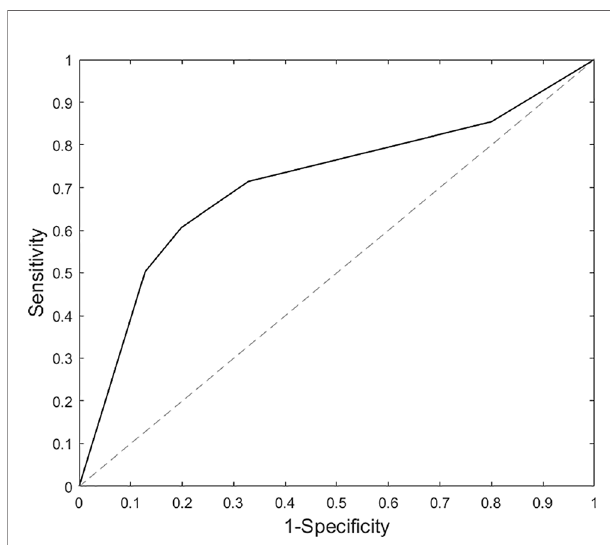
FIGURE 3 | Area under the curve results based on support vector machine analysis for threat (vs. happy)